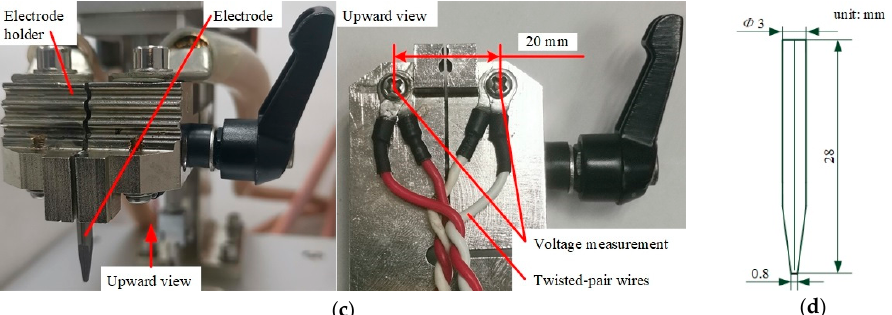
Figure 1. Representation of MRSW: ( a ) schematic diagram of experimental setup; ( b ) a normal weld; ( c ) electrode and its holder; ( d ) main dimensions of electrode.